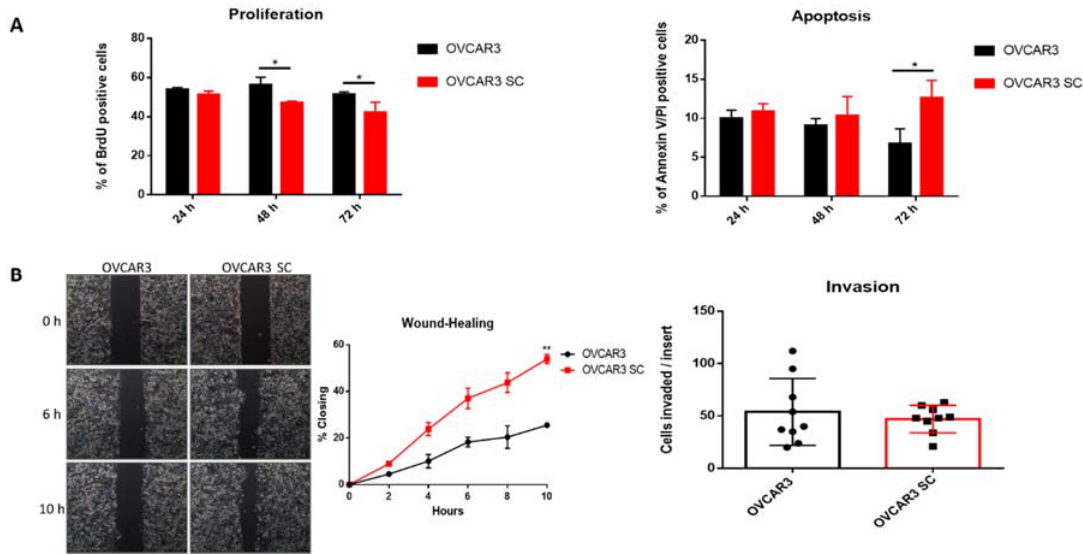
Figure 3. Truncated O ‐ glycans affect the biological behaviour of OVCAR3 cells. ( A ) Flow cytometry analysis of cell proliferation (left) and apoptosis (right), quantified by BrdU and Annexin V/Pi positive cells, respectively. Significantly decreased proliferation was observed in OVCAR3 SC compared with parental OVCAR3 at 48 and 72 h after seeding. Significantly increased apoptosis was observed in OVCAR3 SC compared with parental OVCAR3 at 72 h after seeding; ( B ) Migratory (left) and invasive (right) properties of OVCAR3 and OVCAR3 SC, quantified following wound ‐ healing assays and invasion through Matrigel, respectively. Significantly increased migration was observed in OVCAR3 SC compared with parental OVCAR3. No significant differences were observed in the invasive properties of OVCAR3 SC compared with parental OVCAR3. All experiments were performed in triplicate in at least two independent experiments. Values represent the mean ± SD, * p < 0.05, ** p < 0.01.